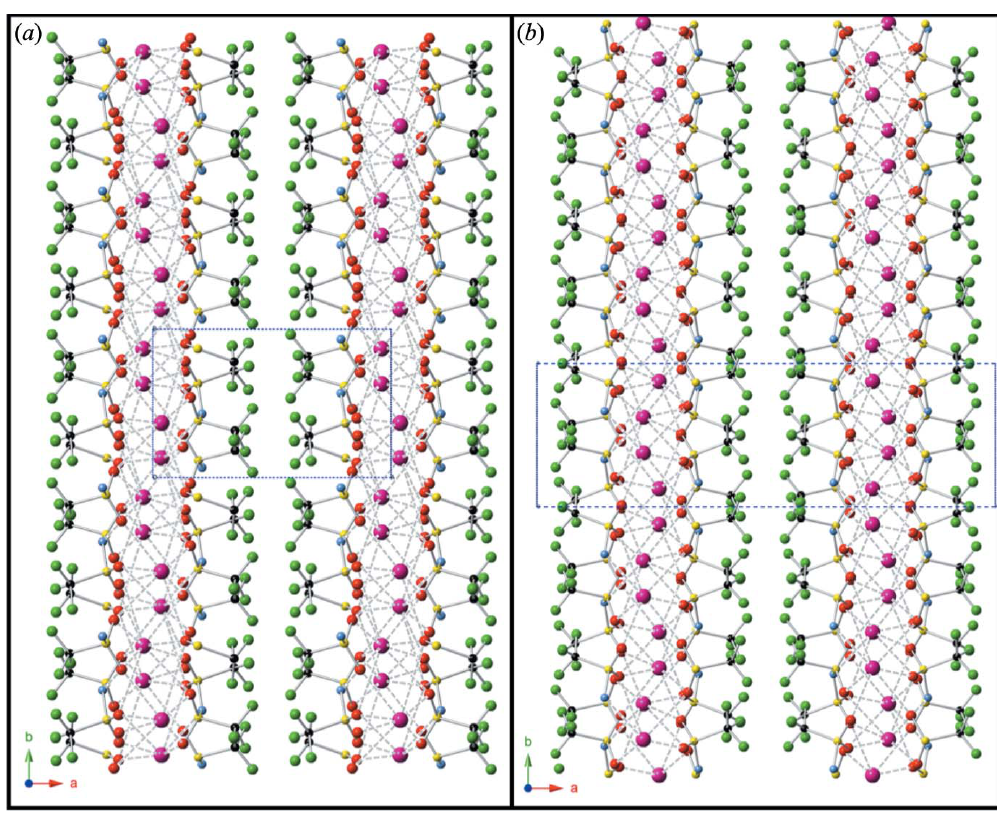
Figure 2 Ball and stick model view along [001] showing the layer of the structure arising from the hydrophobic surfaces formed by orientation of the trifluoromethyl groups, comparing ( a ) the unit cell of the stucture discussed in the paper set in P 2 1 / c and ( b ) that of the previously reported structure set in C 2/ c (Xue et al. , 2002). Atoms are designated as caesium (purple), oxygen (red), sulfur (yellow), nitrogen (blue), carbon (black), and fluorine (green).